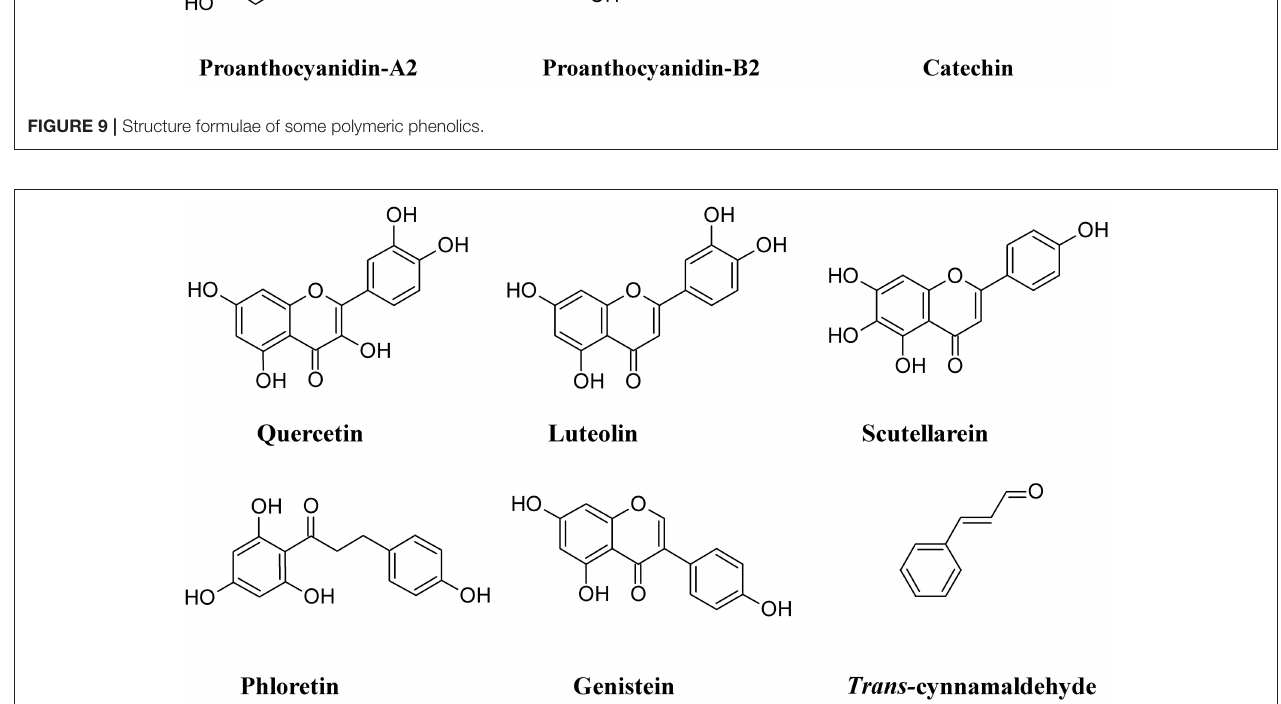
FIGURE 10 | Structure formulae of some non-polymeric